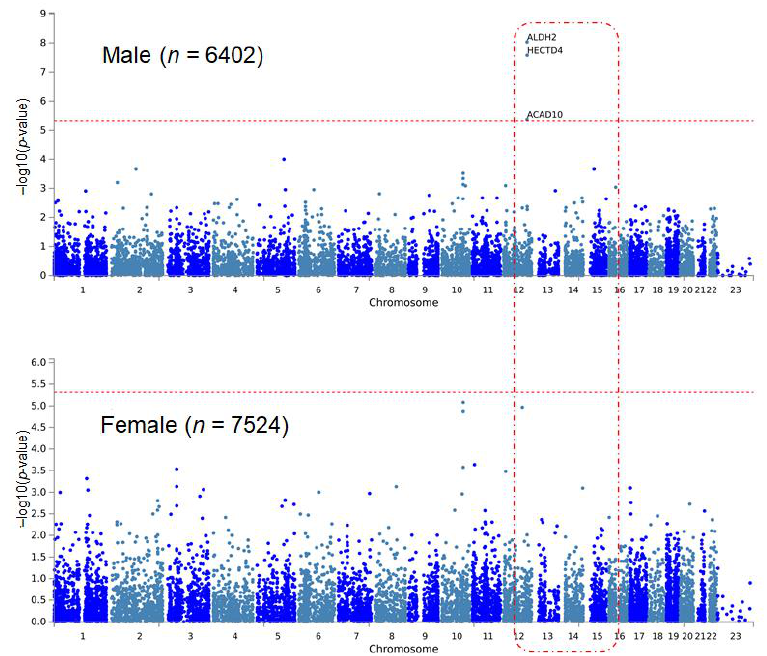
Figure 1. Manhattan plots of sex-stratified MAGMA analysis for hypertension. The Y-axis indicates − log 10 ( p -values), where p -values come from MAGMA analysis. Note that ALDH2, HECTD4, and ACAD10 are significant only in the male population. The red horizontal dotted line indicates the cutoff threshold for statistical significance.